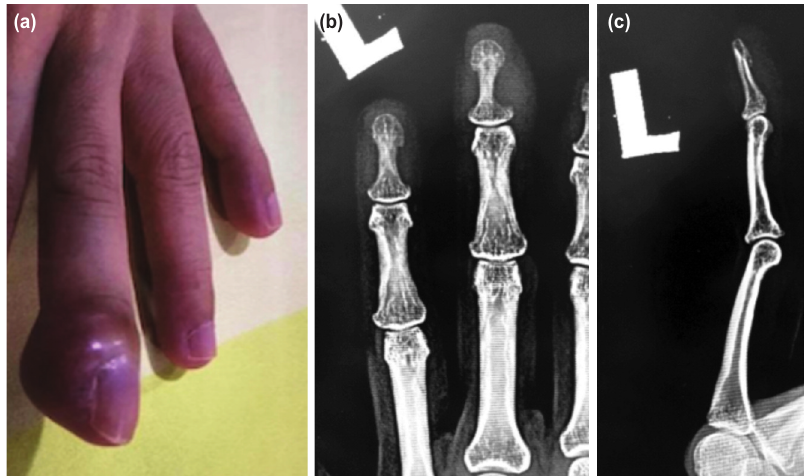
(a) Clinical picture of the left middle finger swelling and erythema mimicking an infection, (b and c) Lateral and AP radiograph Fig. 1: of the left middle finger showing increase in soft tissue shadow and scalloping of the distal phalanx at two and half months after the onset of symptoms.